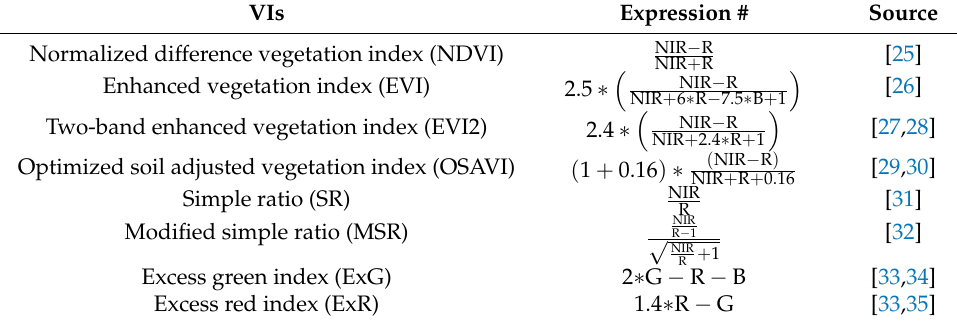
[25] NIR + R (cid:16) [26] (cid:16) (cid:17) NIR − R [27,28] NIR + 2.4 ∗ R + 1 [29,30] NIR + R + 0.16 [31] R [32] NIR + 1 R